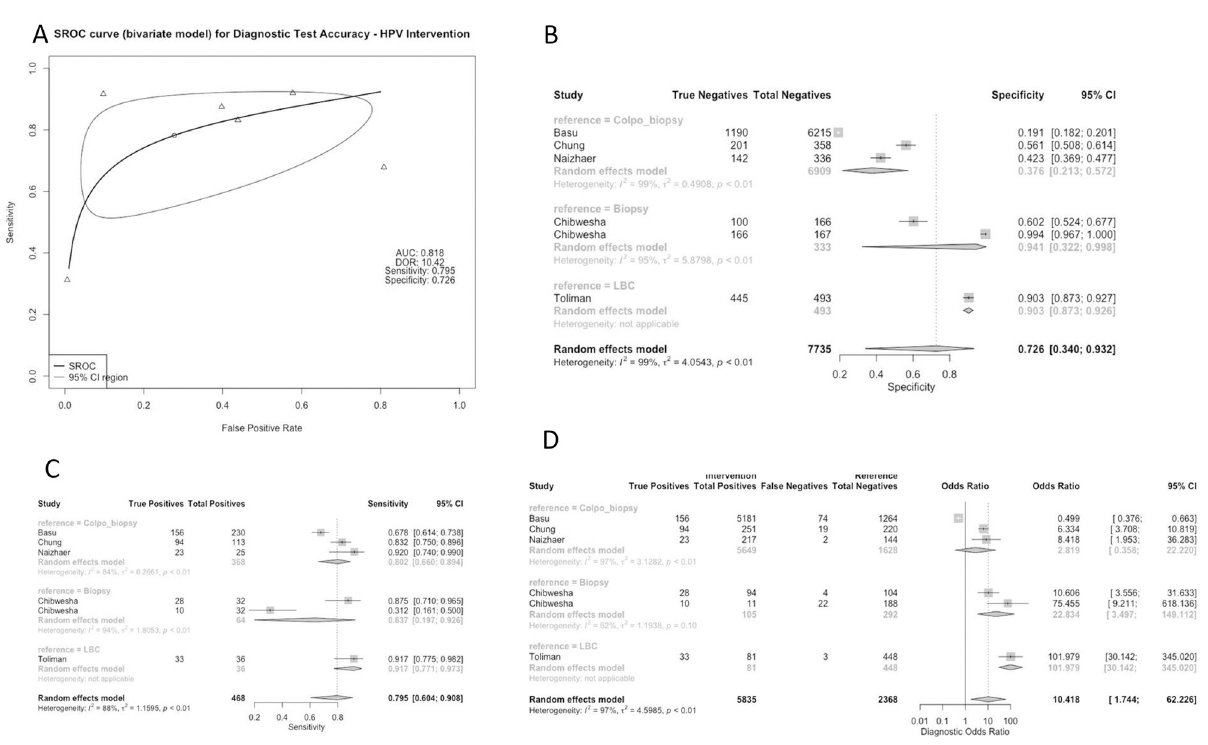
Fig 4. Panel A: Pooled Receiver Operating Characteristic for Diagnostic Test Accuracy for HPV Intervention. Panel B: Specificity of Studies for HPV Intervention. Panel C: Sensitivity of Studies for HPV Intervention. Panel D: Diagnostic Odds Ratio for HPV Intervention.